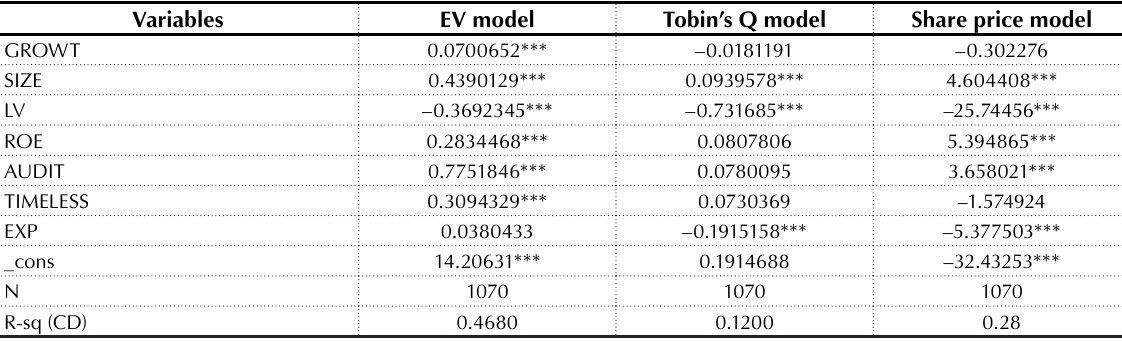
Table 7. Summary of multivariate regression results